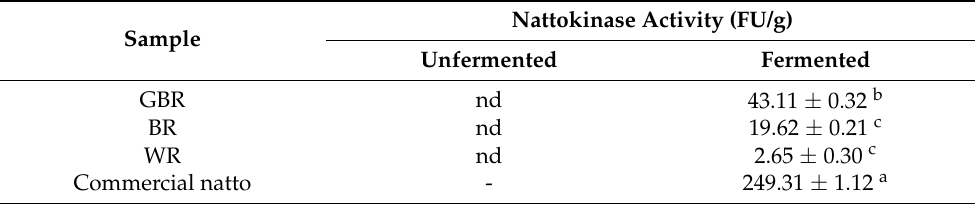
Table 6. Effect of fermentation on the nattokinase activity (FU/g) of rice